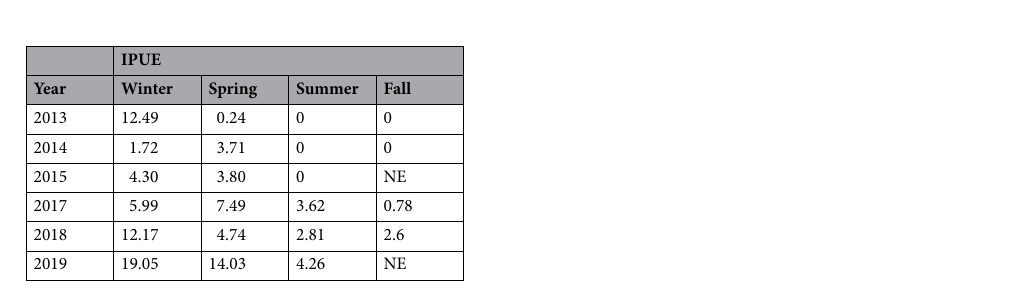
Table 3. Unique individuals per unit effort (IPUE, whales per 1000 km) identified on broad-scale surveys in Southern New England shelf waters. NE = no survey effort.